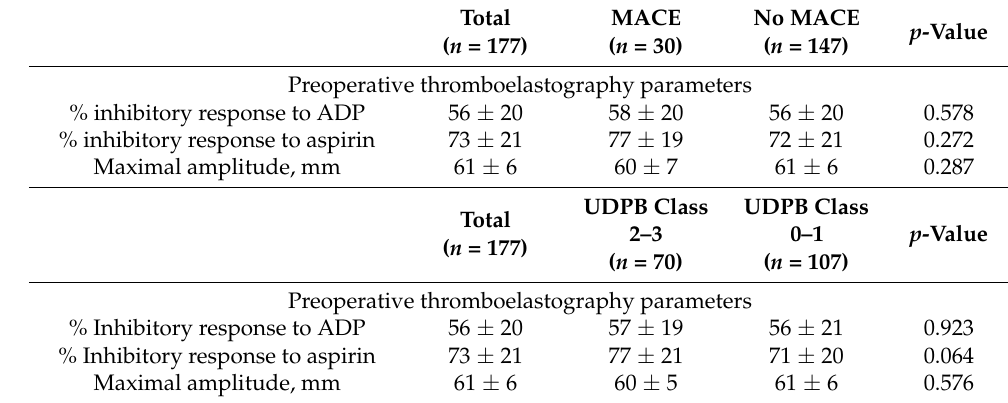
Table 3. Preoperative thromboelastography